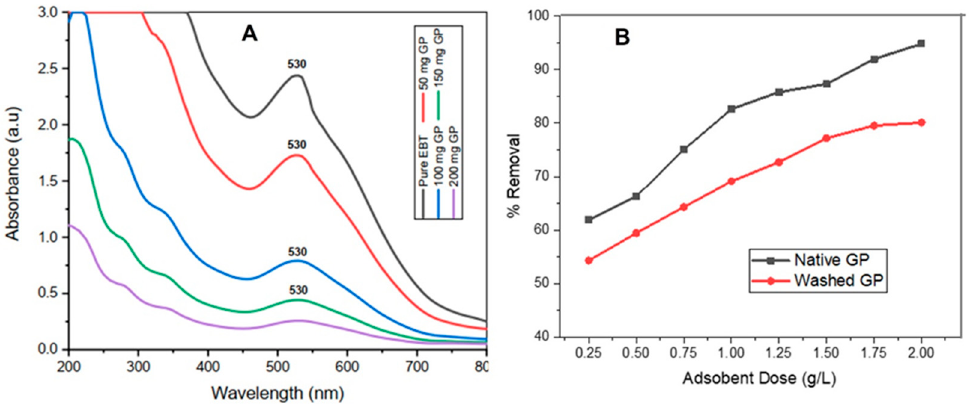
Figure 5. ( A ) Effect of adsorbent dose on the λ max of EBT ( B ) Effect of adsorbent dose on the removal of EBT.